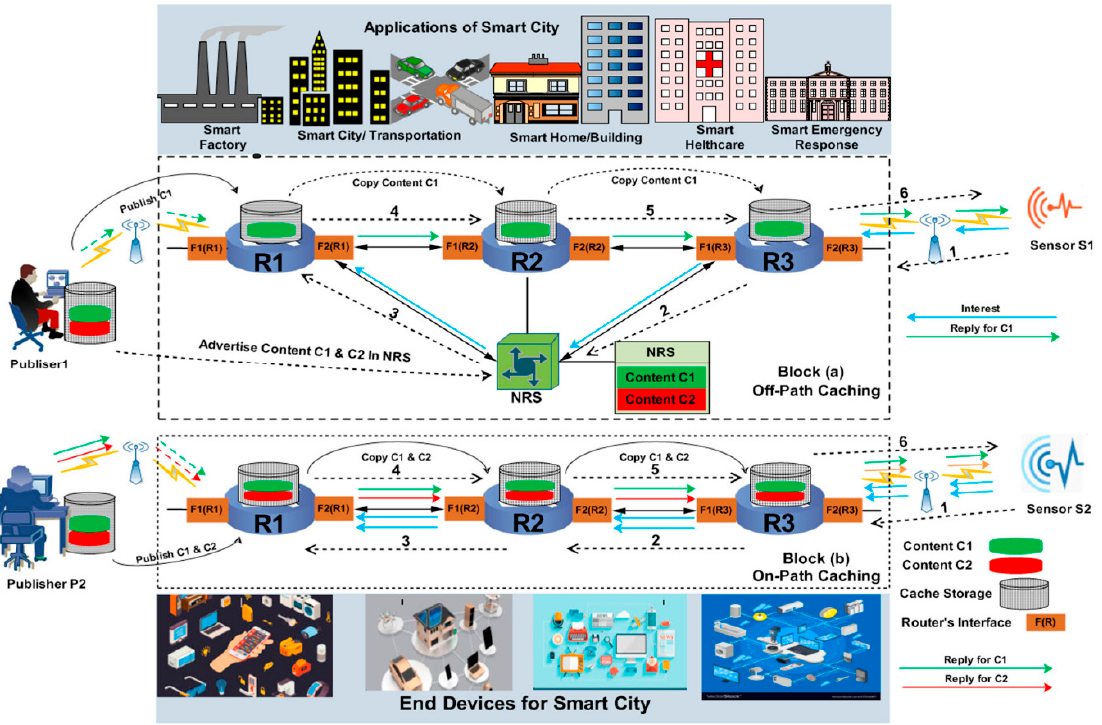
Figure 7. Representation of off-path and on-path caching mechanism in smart city [87].